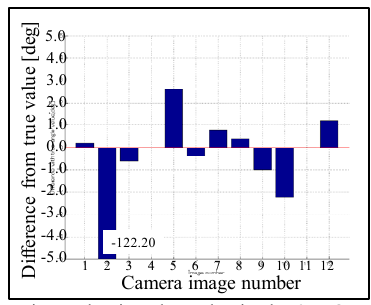
Figure 15. Estimated azimuth angles in the 3-DOF (narrow range)